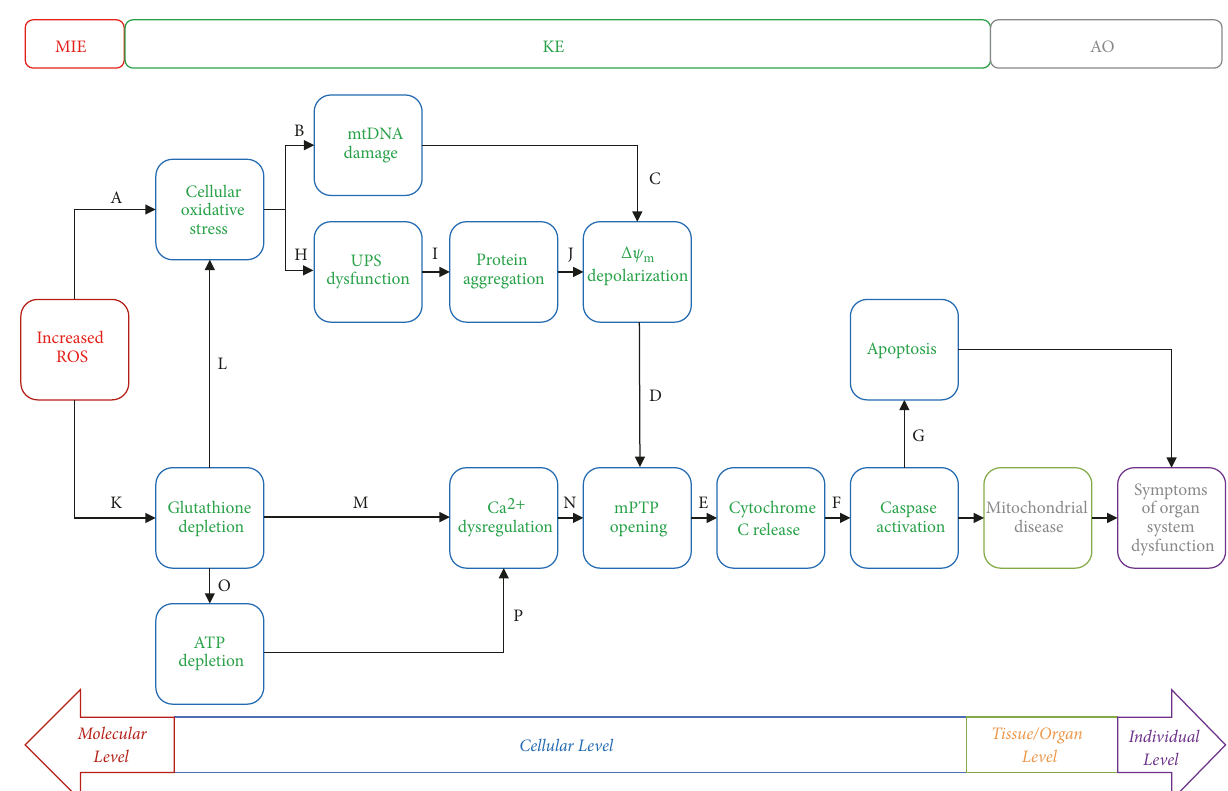
Figure 3: Graphical representation of organohalogen exposure to mitochondrial disease AOP. Key events at the molecular and cellular levels lead to AOs at the tissue/organ and individual levels. Exposure to organohalogens cause increased ROS production (Molecular Initiating Event, MIE), triggering the key events (KEs) that result in the adverse outcome (AO), defined as the onset of mitochondrial disease and the associated symptoms of organ symptom dysfunction. This AOP depicts 2 distinct pathways from MIE to